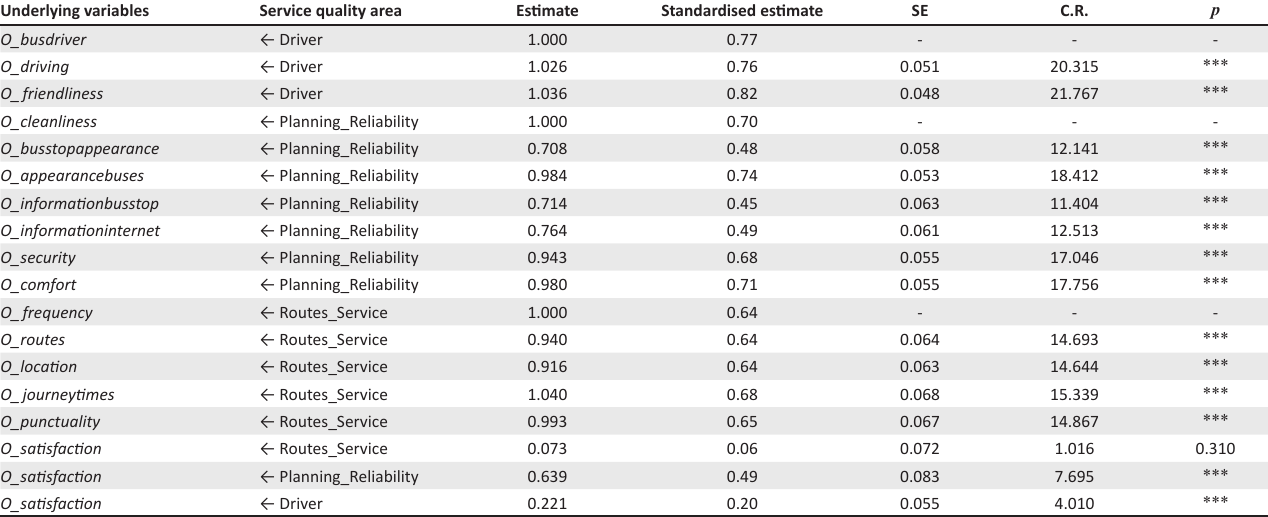
TABLE 11: Final model attribute estimation and significance levels. Underlying variables Service quality area